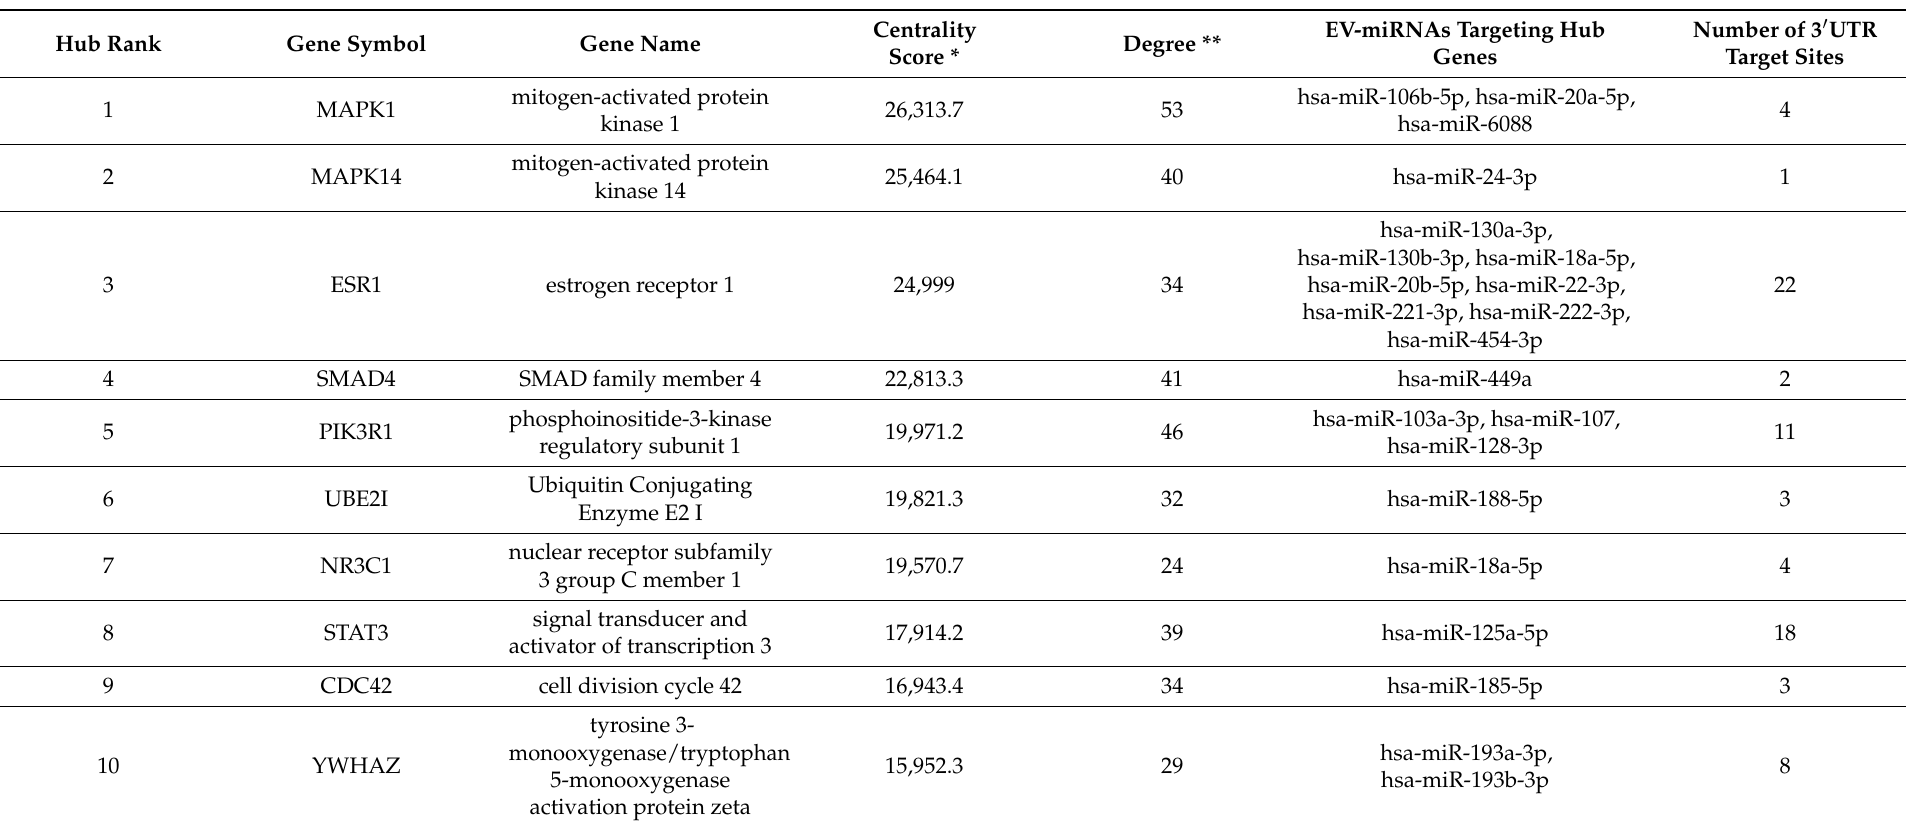
Table 1. Top-10 hub genes identified in the merged PPI network and correspondent targeting